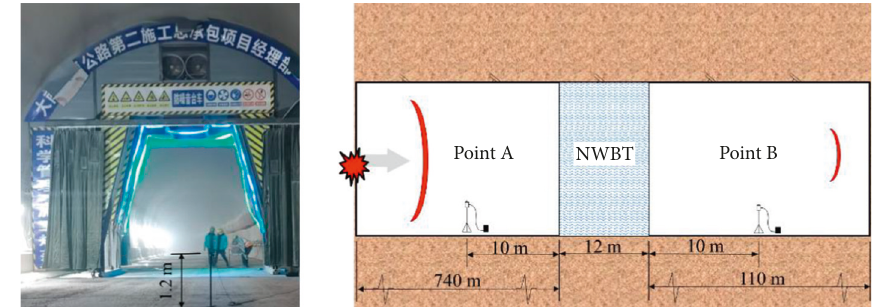
Figure 6: Arrangement of the measuring